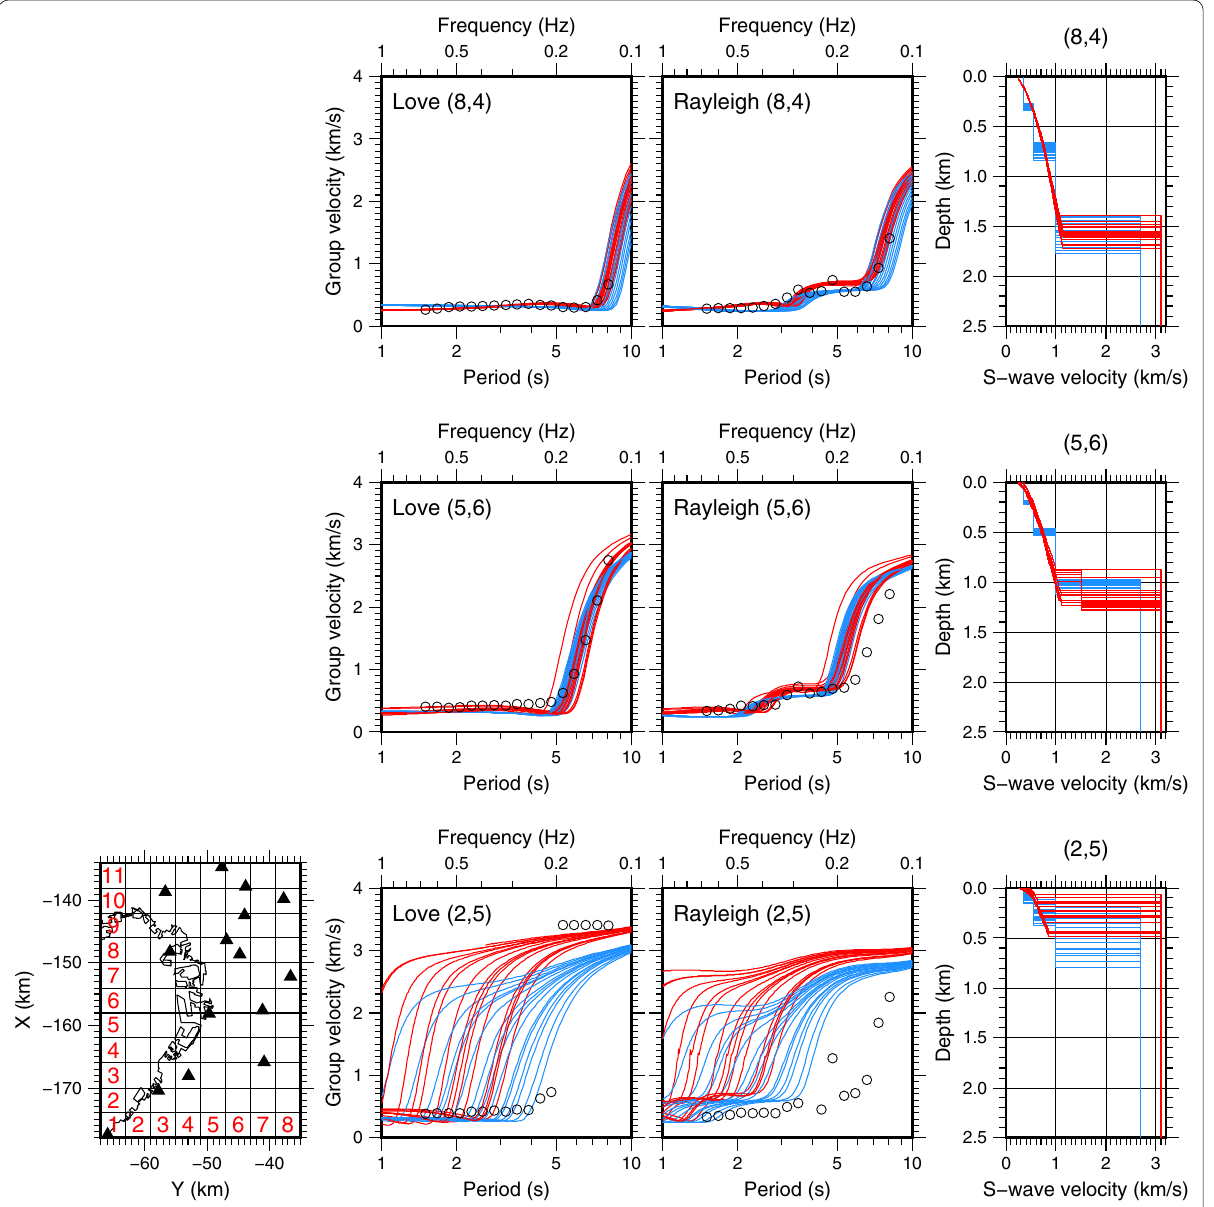
Fig. 12 Comparison among Love and Rayleigh wave group velocities ( open circles ) estimated from tomography analysis and the theoretical disper- sion curves from the UMC2013 model ( red line ) and Iwata et al. (2008) model ( blue line ) at cells ( I x , I y ) number of cells in the X and Y directions, respectively, as shown on the map. The S-wave velocity profiles corresponding to theoretical dispersion curves are shown in the right